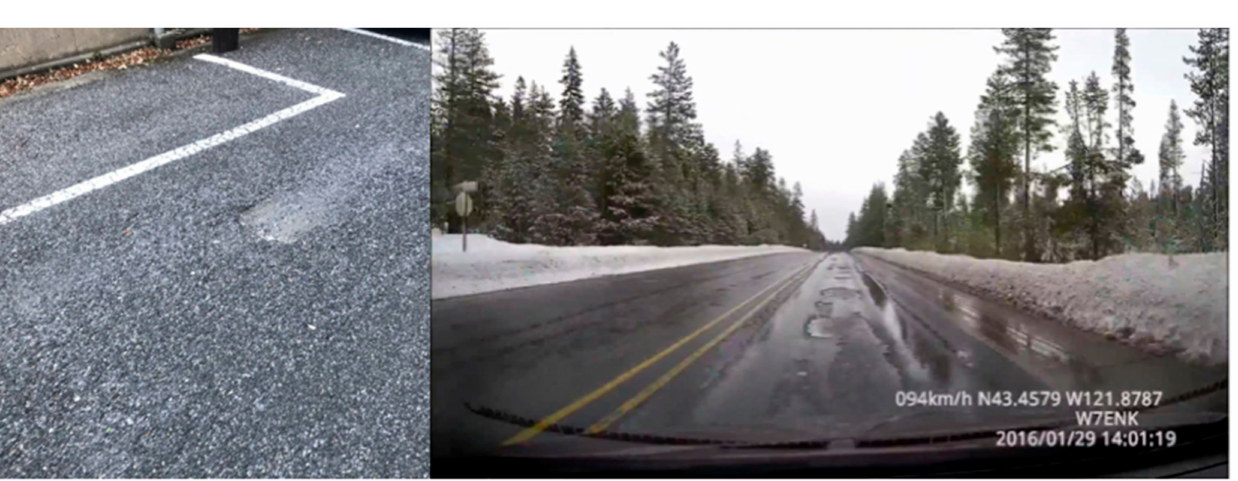
Figure 1. A more realistic task of pothole detection presented in the right column compared to an unrealistic